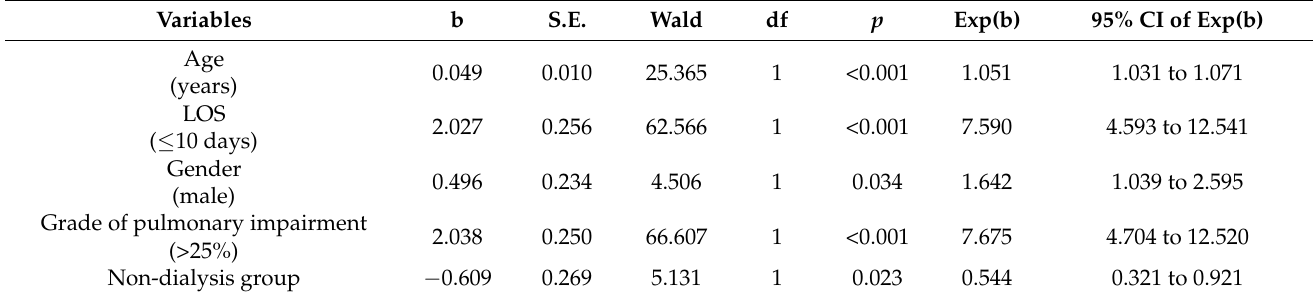
Table 4. The relative instantaneous risks of mortality in the non-dialysis